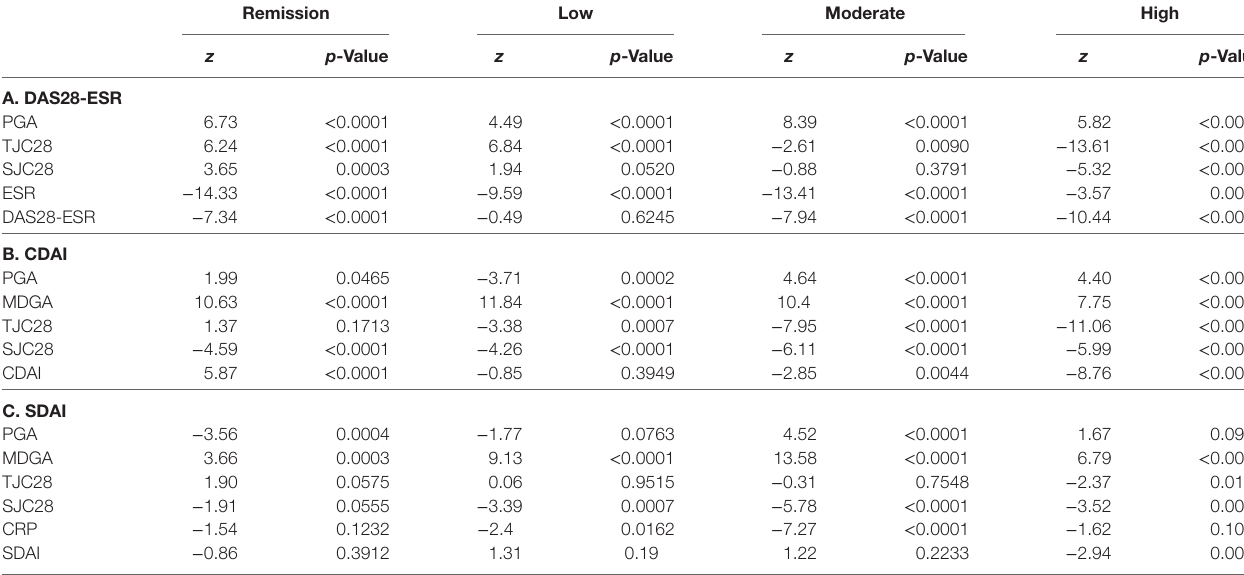
TaBle 5 | Comparison of the mean scores from the individual components of each disease activity evaluation between the Dutch and Portuguese populations. remission low Moderate